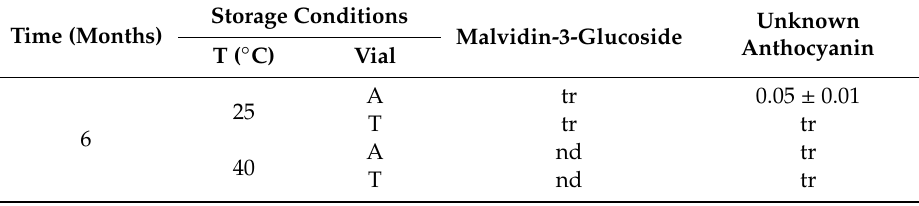
Table 3. Kinetic parameters for the unknown anthocyanin degradation in grape stem extracts stored under different conditions. Storage Conditions